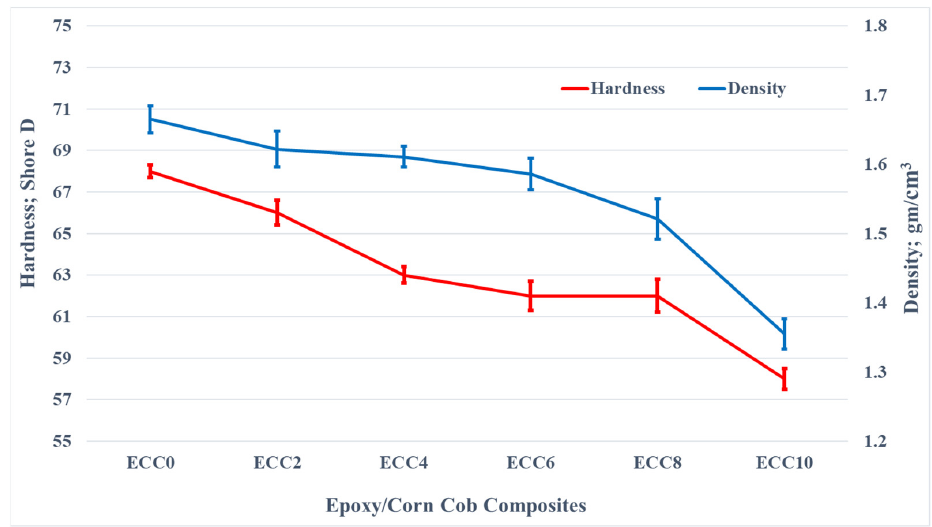
Figure 5. Density and shore-D hardness of epoxy/corn cob composites.